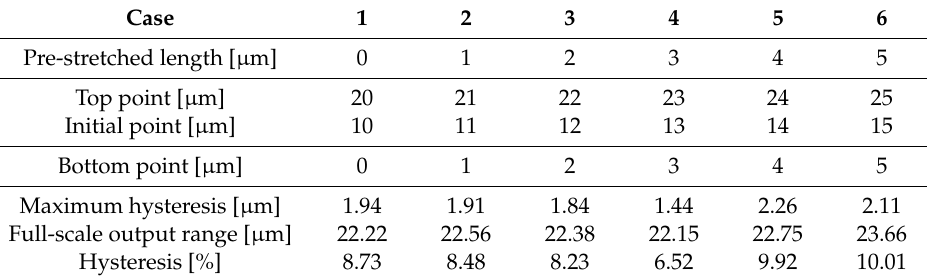
Table 5. Analysis of hysteresis according to the pre-stretched lengths.